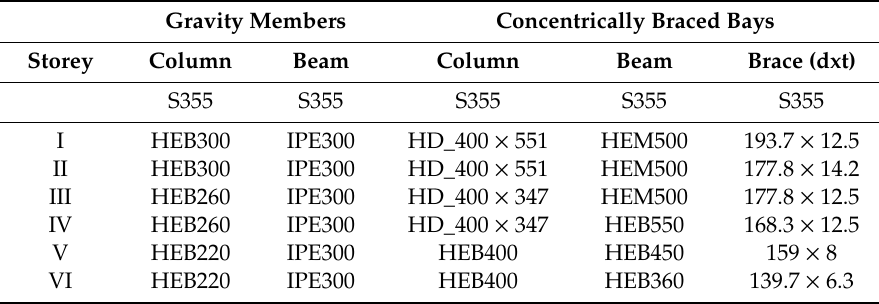
Table 2. Structural members for 6-Story CCBF.